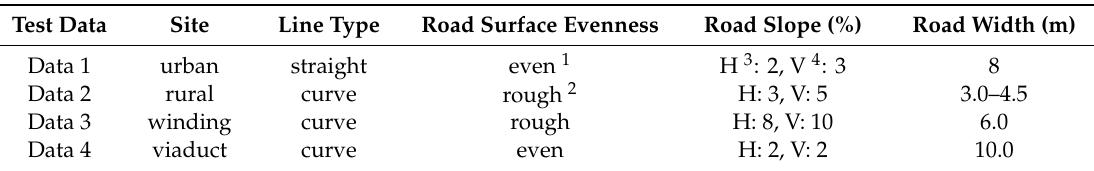
Table 1. Test data environment.